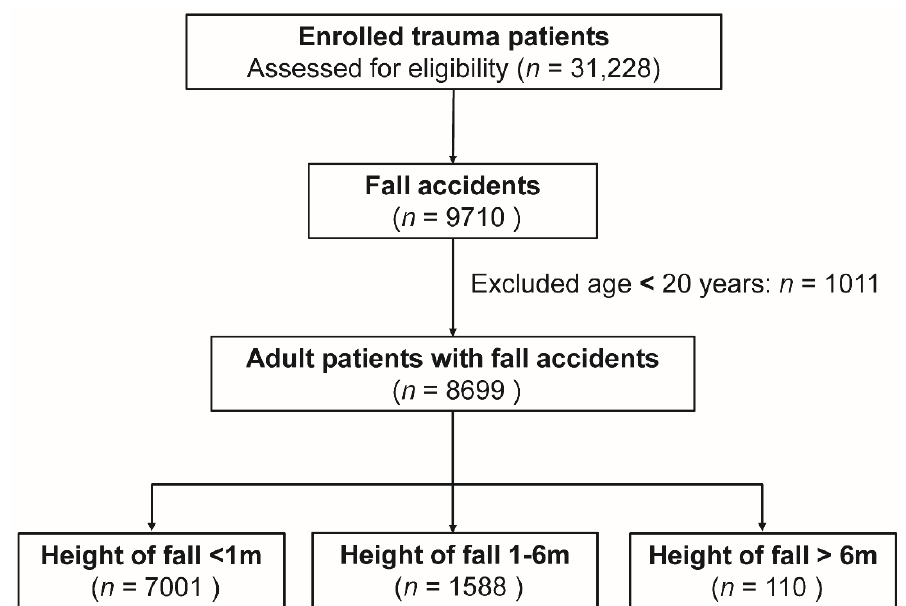
Figure 1. Flow chart illustrating the inclusion of patients with a fall from the height of <1 m (m), 1–6 m, and >6 m.